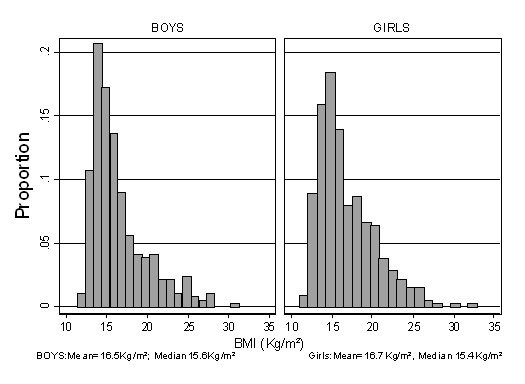
Distribution of BMI in boys and girls separately.